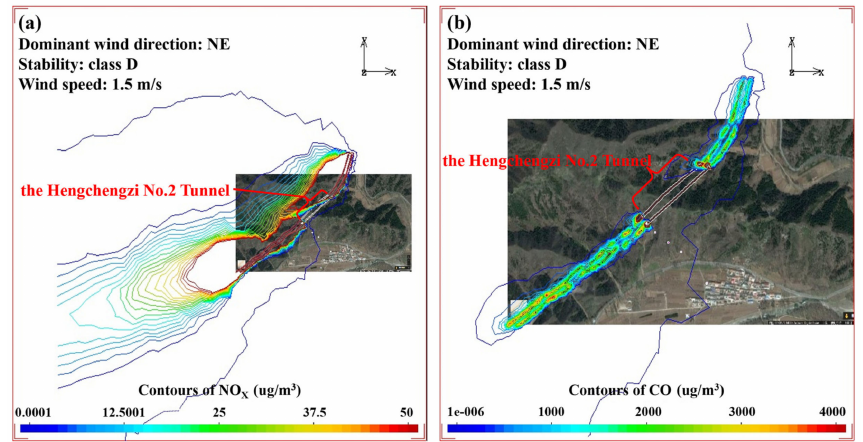
Figure 12. Concentration distribution of NO X and CO under the dominant wind direction in the Hengchengzi No. 2 Tunnel section. ( a ) NO X ; ( b ) CO.